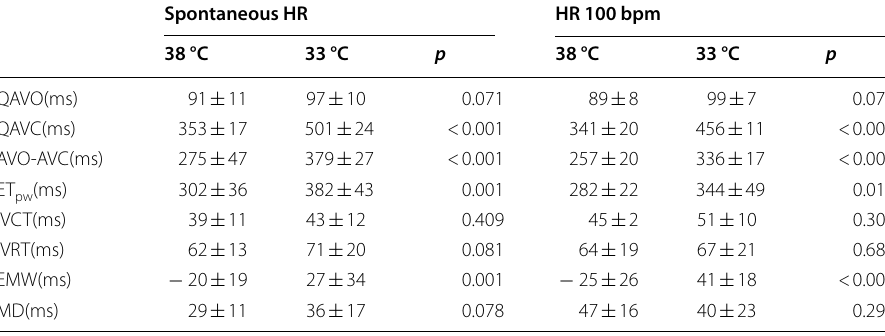
Data are expressed as mean